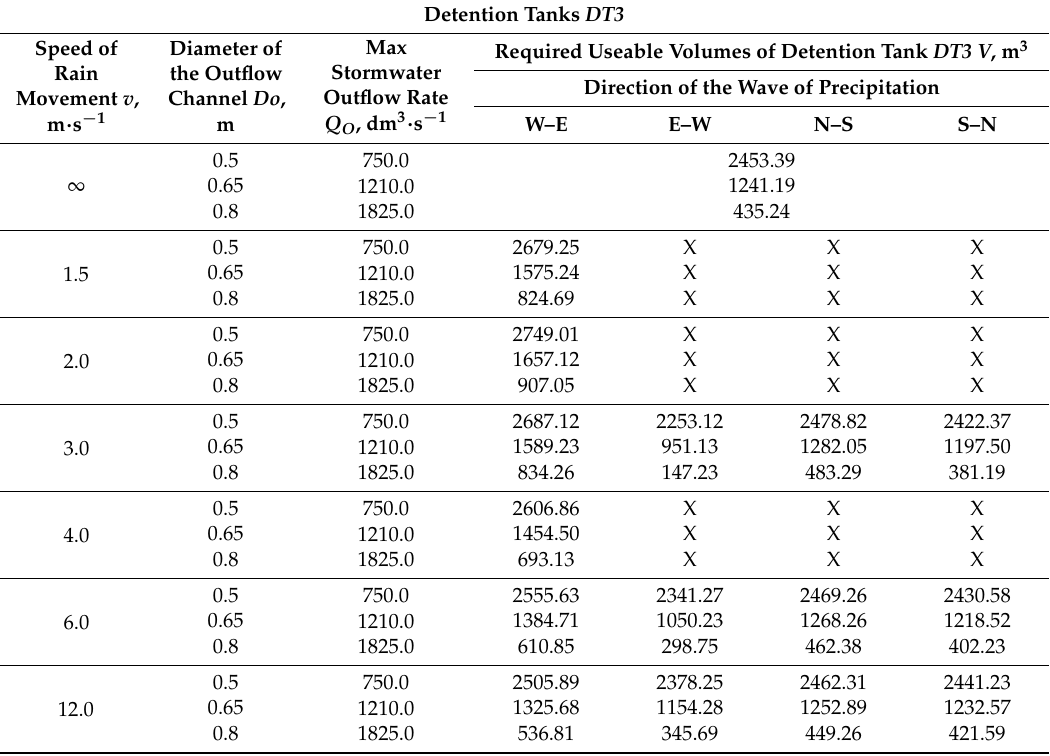
Table 3. Required volumes of detention tanks DT3 determined at the specific diameter of the outflow channels from reservoirs DT1 and DT2 , D O = 0.3